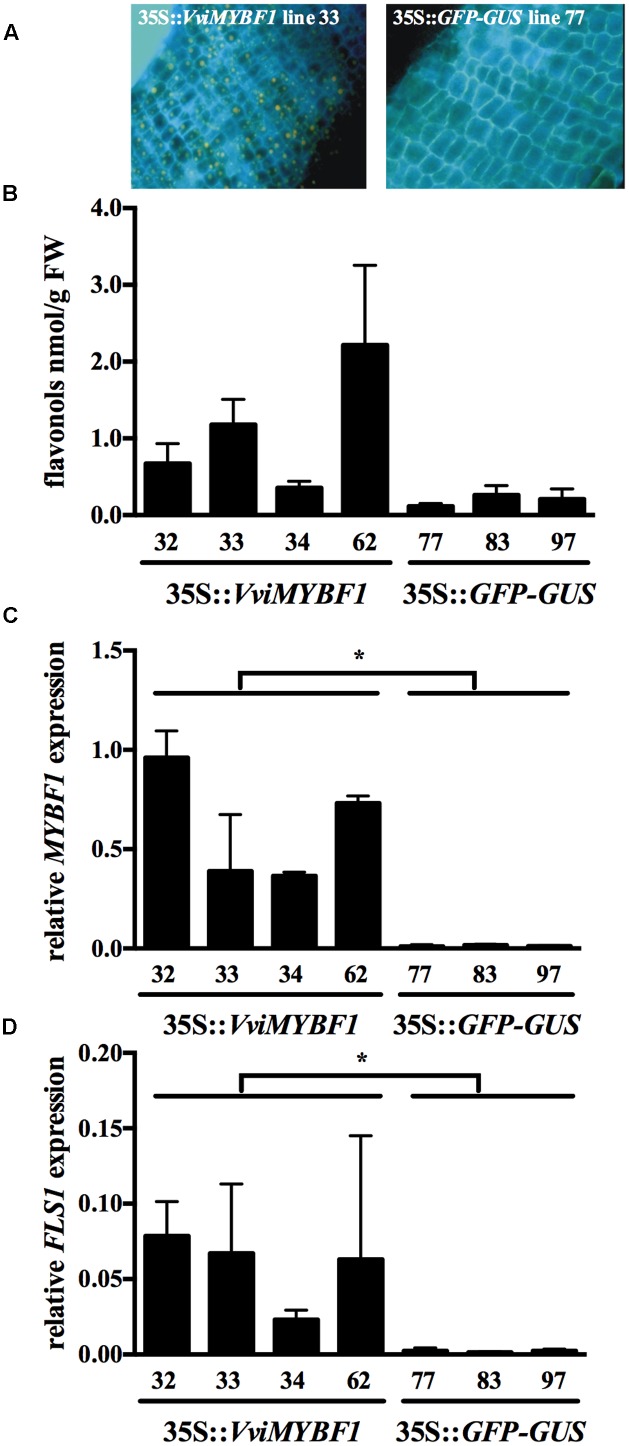
Selection of transgenic hairy root (HR) lines. Lines for microarray analysis were selected under the following criteria: flavonol accumulation as visualized by fluorescence microscopy on in situ diphenylboric acid-2- aminoethylester (DPBA) stained root cross sections (A), flavonol content as shown by high performance liquid chromatography (HPLC) analysis (B) and gene expression analysis to verify transcript levels of the VviMYBF1 transgene and its well-characterized target VviFLS1
(C,D). DBPA staining analysis shown in (A) was conducted with sections of the VviMYBF1 line 33 (left) and control line 77 (right). HPLC results in (B) are the mean values of three independent extractions from the same biological material. Gene expression analysis in (C,D) is shown relative to the expression of UBIQUITIN1 gene (previous TIGR database id: TC32075, VIT_16s0098g01190) with standard deviations derived from three qPCR runs with three technical replicates each. Stars indicate significant differences (p < 0.05) between MYBF1 and control HRs based on t-test.